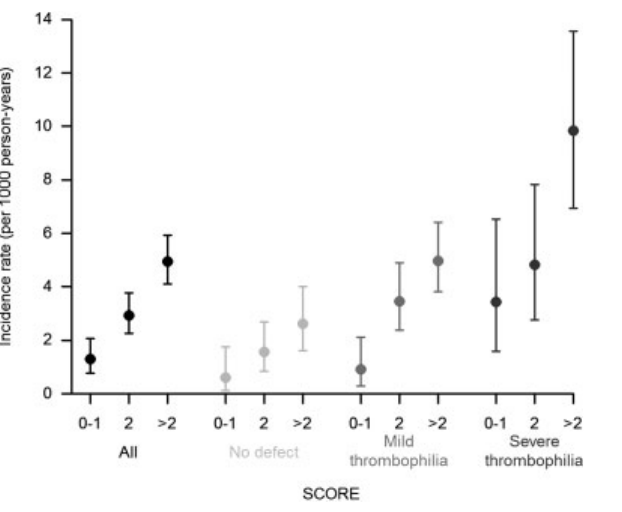
Fig.2 ROC curve of the risk score combining fi ve common factors and the thrombophilia status. AUC ¼ 0.702 (95% con fi dence interval, 0.666 – 0.739). TH Open Vol. 3 No.